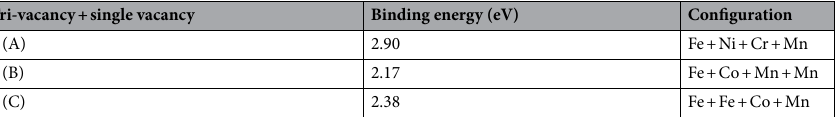
Tri-vacancy + single